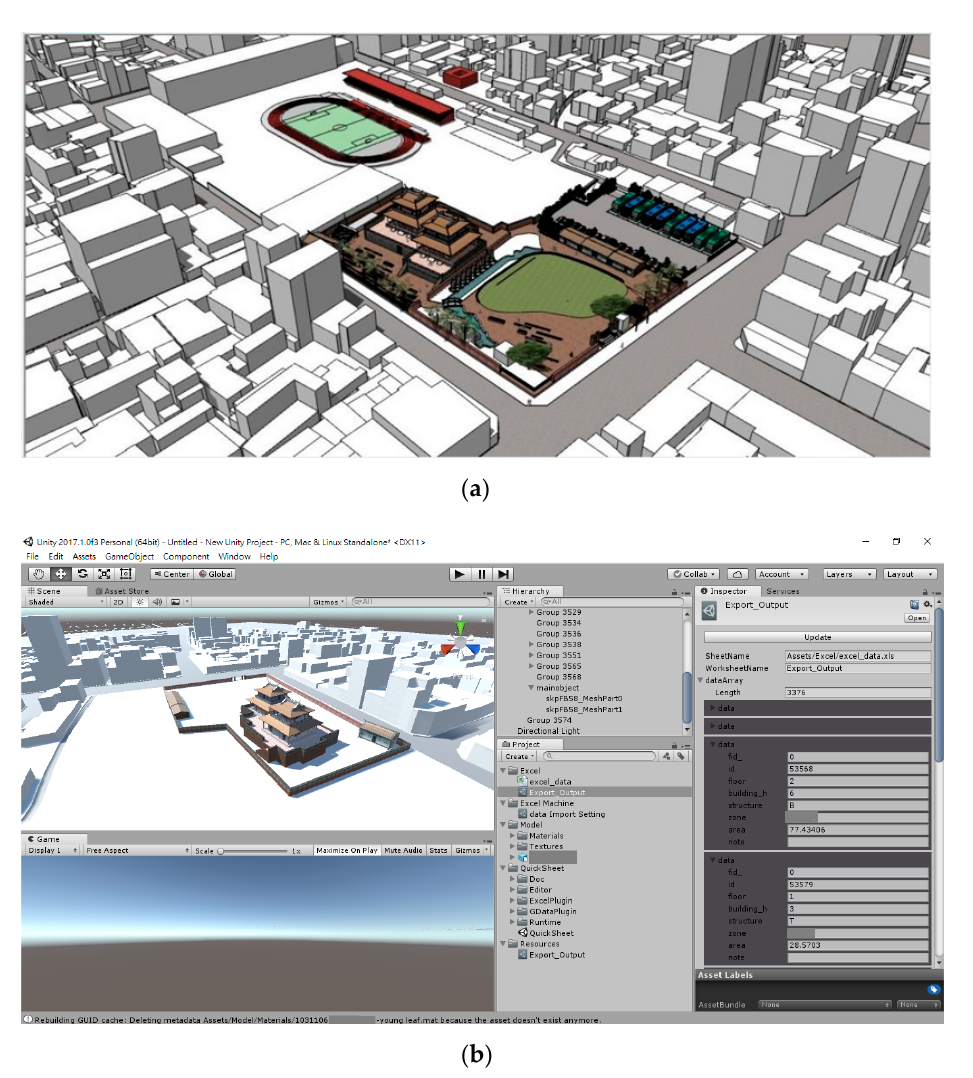
Figure 3. Research subjects and tools: (a) the old city street around Chi Kan Tower, Tainan City, Taiwan, was taken as the display object; (b) 2D and 3D information models were built with ArcGIS and SketchUp, and Unity3D was used as the game engine development software.